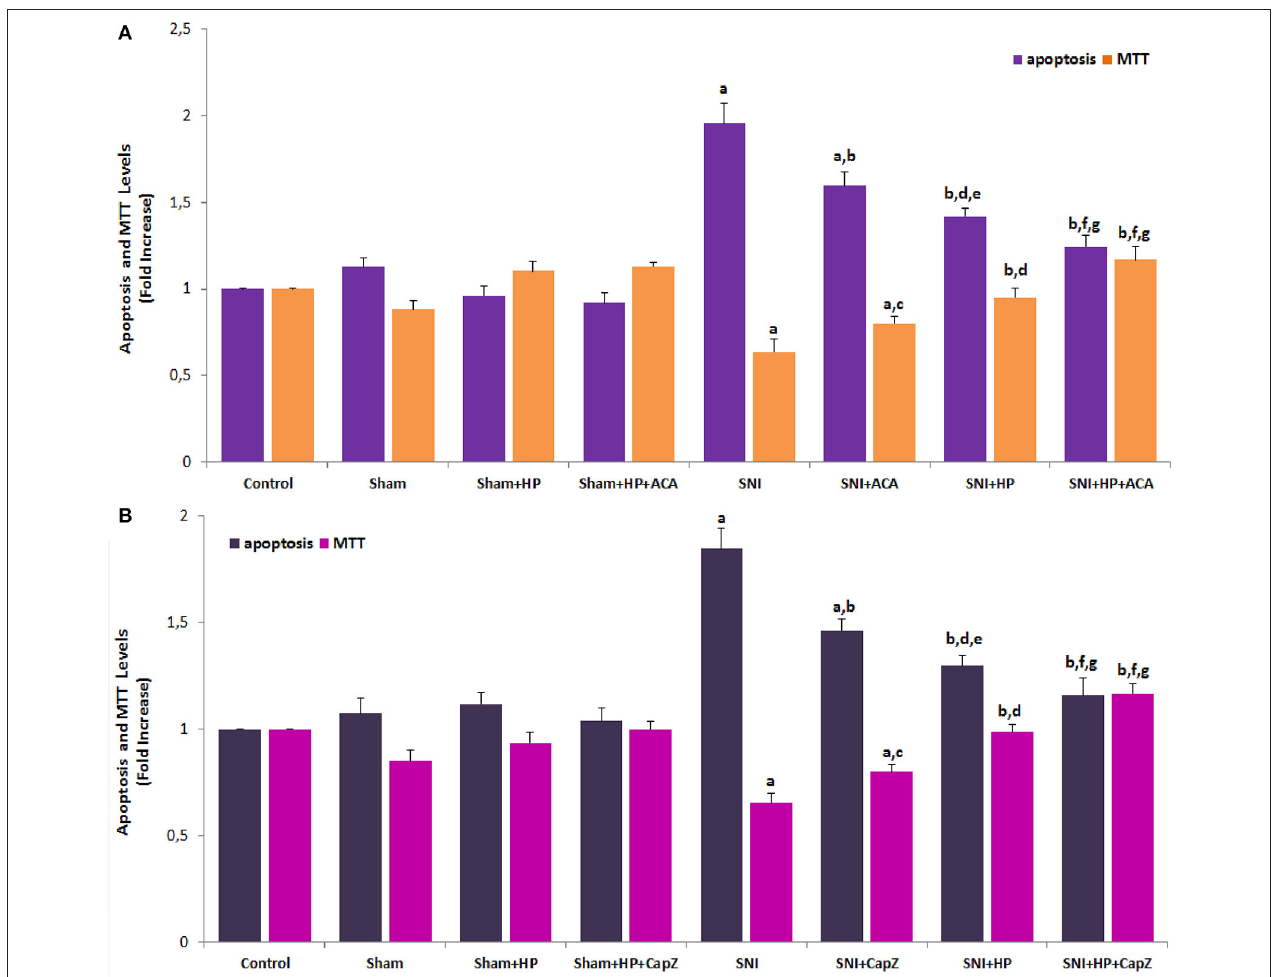
FIGURE 6 | Effects of Hypericum perforatum (HP) on the apoptosis and cell viability (MTT) levels through TRPM2 (A) and TRPV1 (B) in sciatic nerve of SNI-induced rats (mean ± SD and n = 3). Apoptosis level was measured by using a commercial kit. Values expressed as fold increase (experimental/control). These neurons were dissected from control, SNI and treated animals. The animals were received HP via gastric gavage. The neurons in TRPM2 and TRPV1 experiments were stimulated with cumene hydroperoxide (CPx and 0.1 mM) capsaicin (CAPS and 0.01 mM) although they were inhibited by ACA (0.025 mM) and CapZ (0.1 mM), respectively. ( a p ≤ 0.001 and e p ≤ 0.05 vs. control, sham, sham + HP, sham + HP + ACA and sham + HP + CapZ groups. b p ≤ 0.001 and c p ≤ 0.05 vs. SNI group. d p ≤ 0.05 and f p ≤ 0.001 vs. SNI + ACA and SNI + CapZ groups. g p ≤ 0.05 vs. SNI + HP